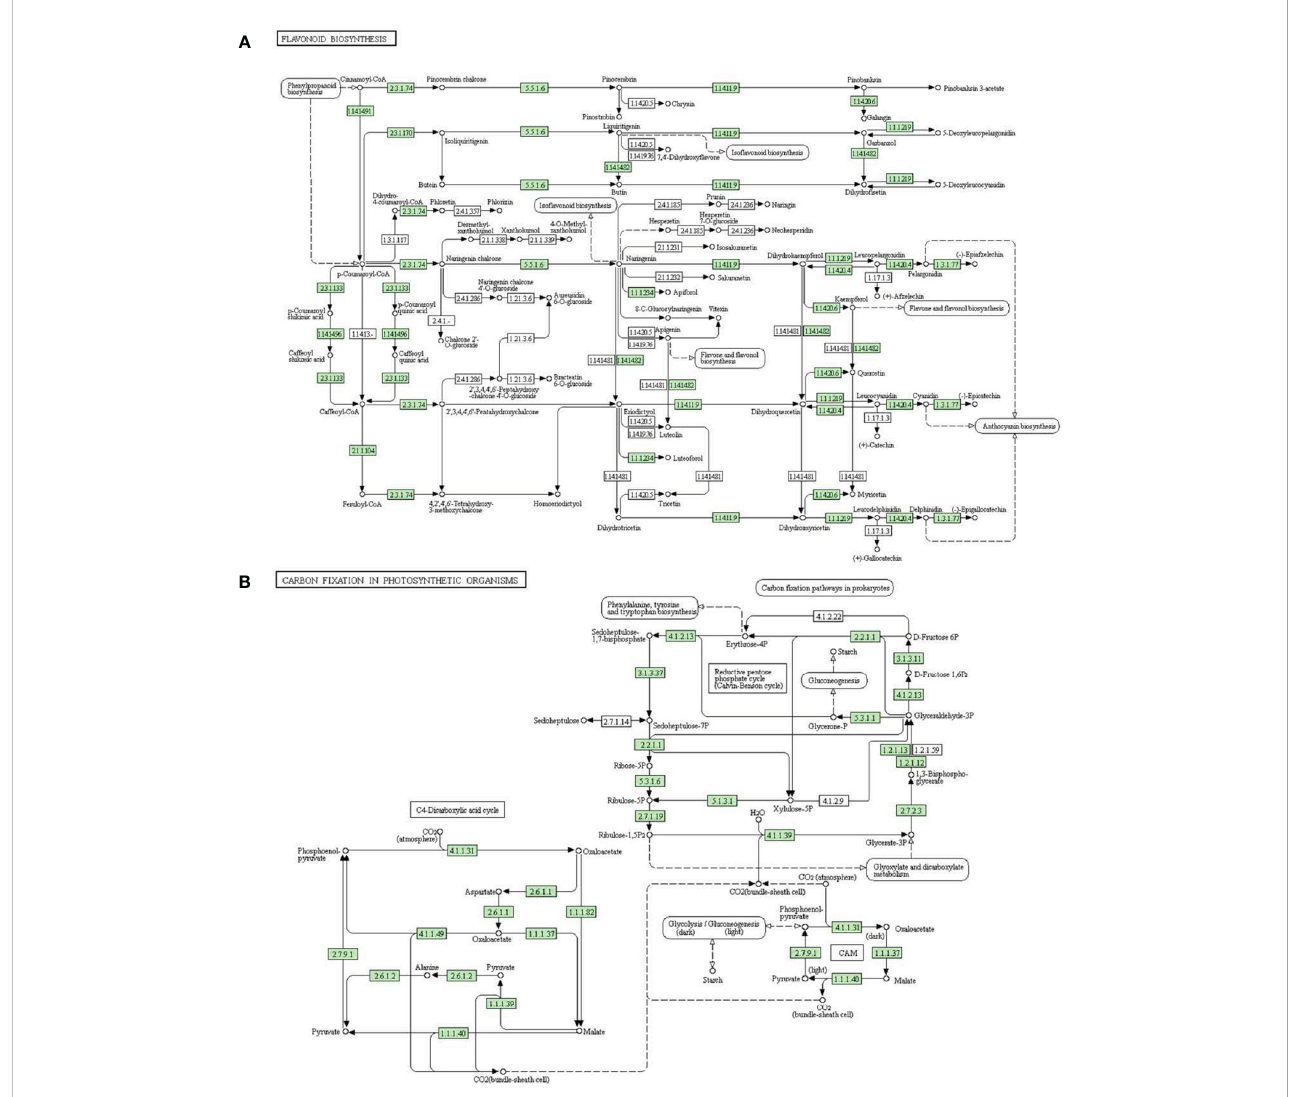
FIGURE 7 Targets of DElncRNAs in two enriched pathways. (A) Flavonoid biosynthesis pathway. (B) Carbon fi xation in photosynthetic organisms